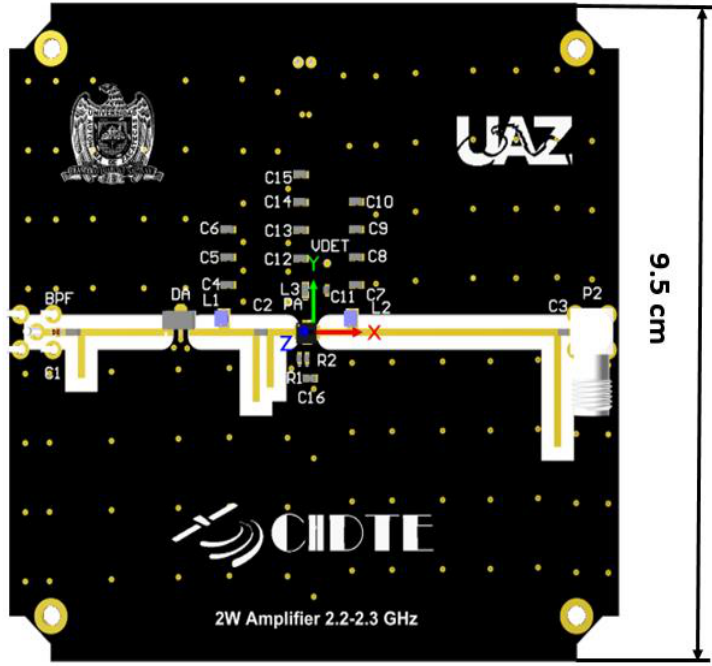
Figure 4. Final approach of the signal conditioning stage.